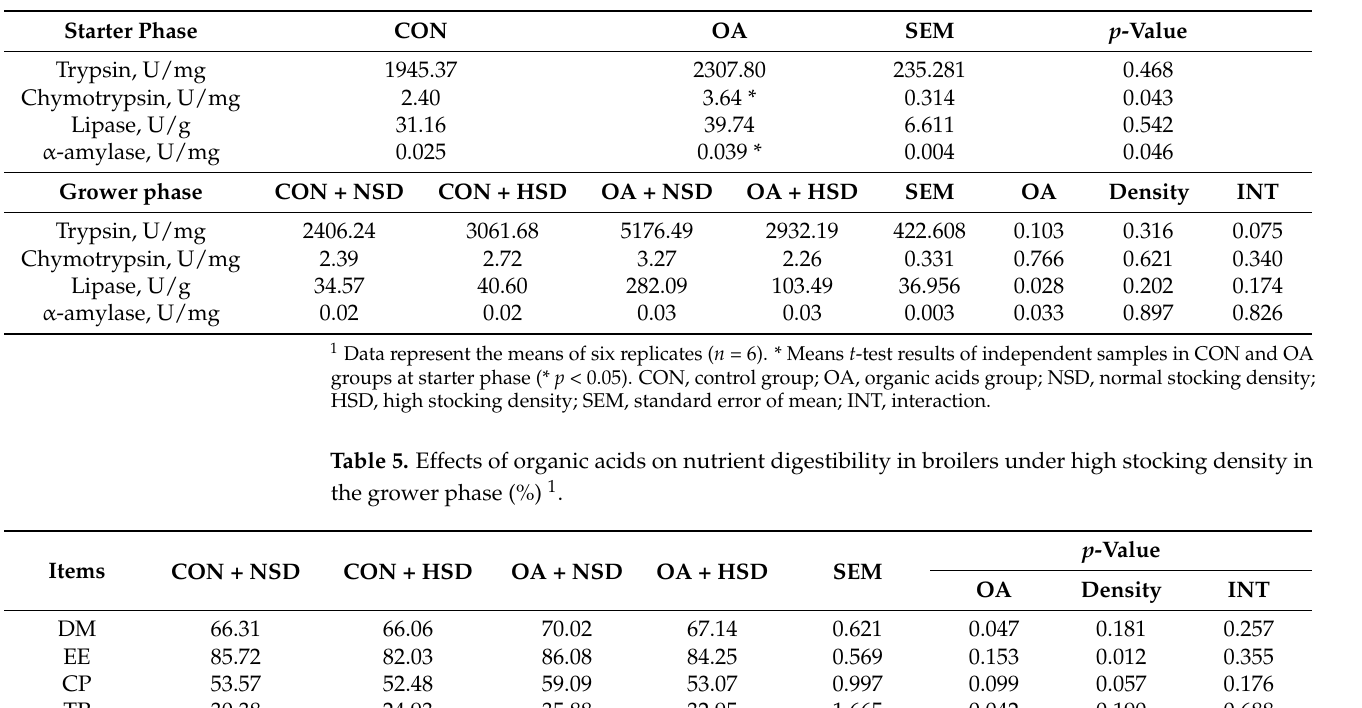
Table 4. Effects of organic acids on enzyme activities in duodenal chyme in broilers at the starter and grower phases 1 .